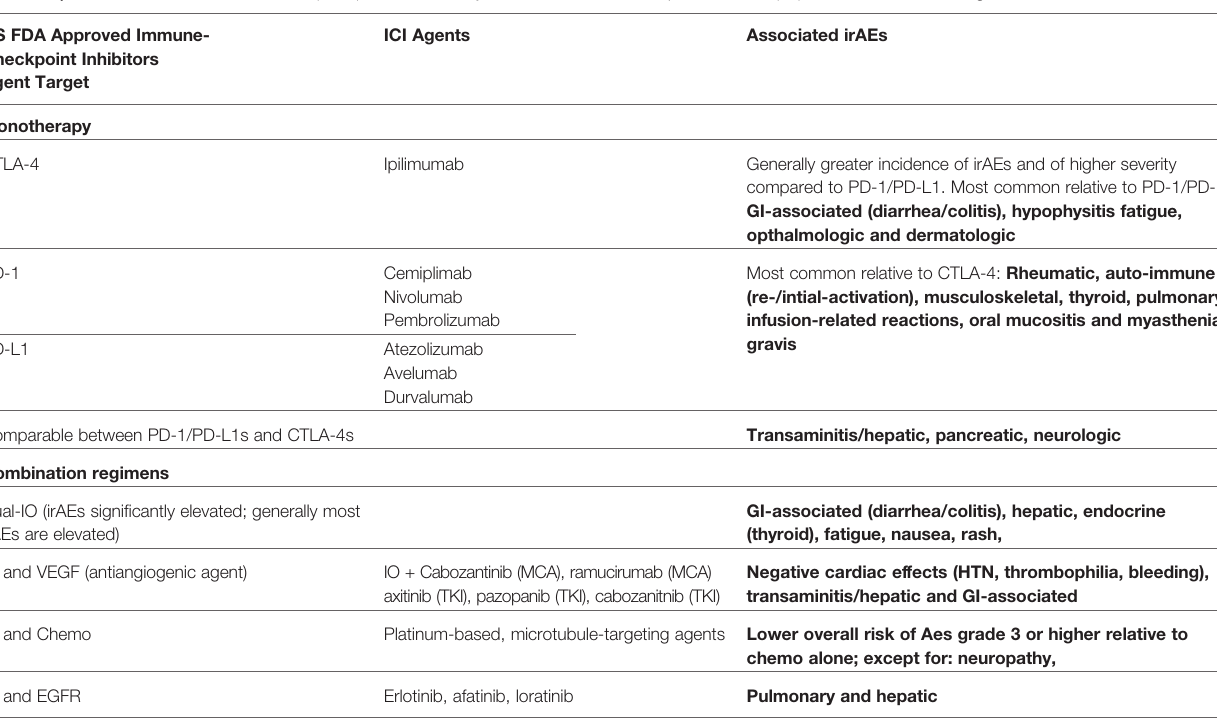
TABLE 2 | Immune-related Adverse Events (irAEs) Associations by Class of Immune Checkpoint Inhibitor (ICI) or ICI-Combination